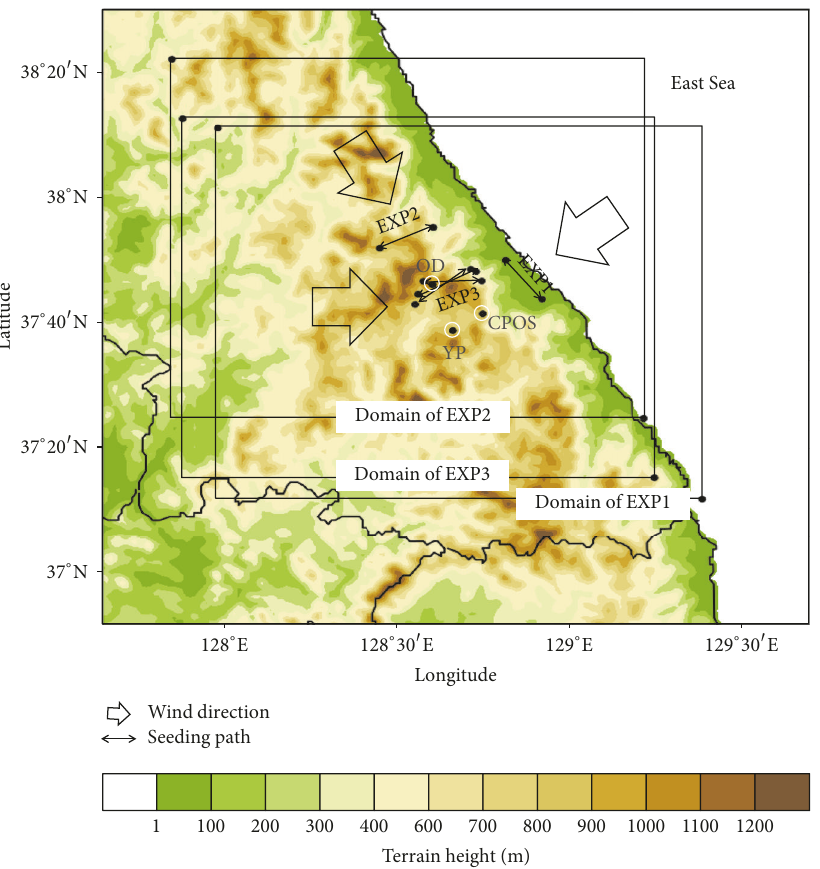
Figure 1: Topography of the experimental region. The OD, YP, and CPOS are the observation sites at Ode mountain, Yongpyeong, and Daegwallyeong, respectively, with the snow-depth meter, MRR (Micro Rain Radar), PARSIVEL (particle size and velocity disdrometer), and AWS (Automatic Weather System, which included measuring the temperature, wind, humidity, and a rain gauge). The seeding flight paths were repeated four times perpendicular to the direction of wind at the seeding height, except for EXP3 where the seeding path was changed during the seeding period. The heights of the three observation sites are 960m (OD), 843 m (CPOS), and 771m (YP) above mean sea